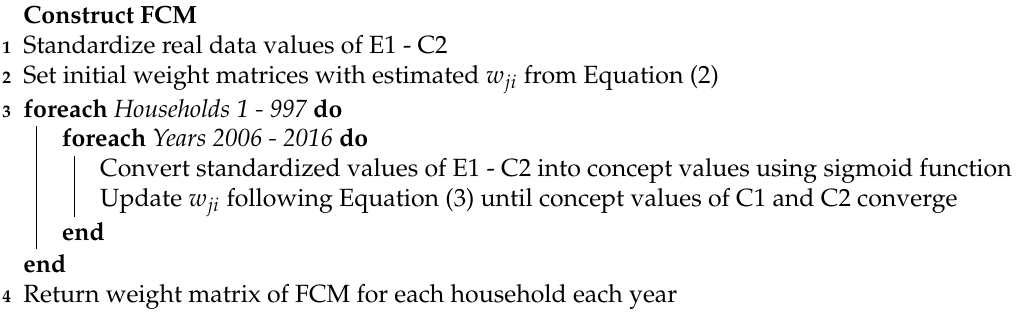
Algorithm 1: Forecasting Household Consumption and Weekly Working Hours with FCM Construct